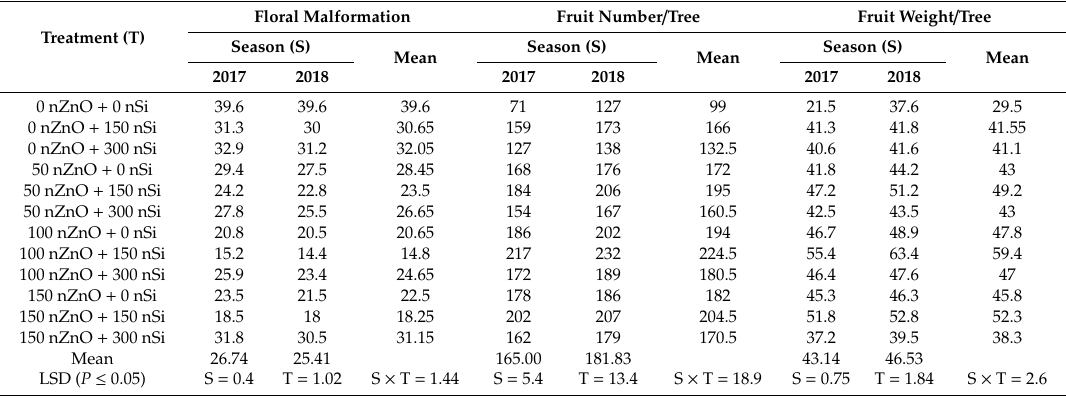
Table 6. E ff ect of foliar spray with ZnO and Si NPs (mg / L) on floral malformation (%), total fruit number, and fruit weight (kg) of “Ewais” mango trees during the 2017 and 2018 seasons. Floral Malformation Fruit Number / Treatment (T)